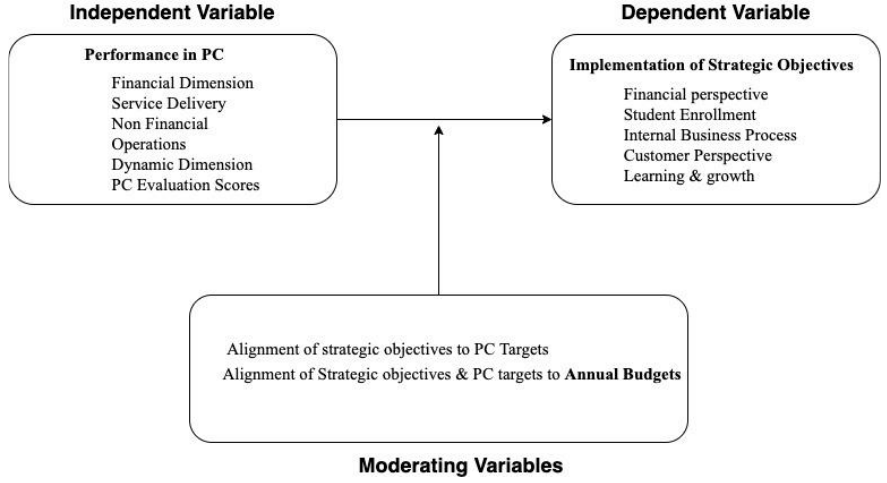
Figure 1: Conceptual